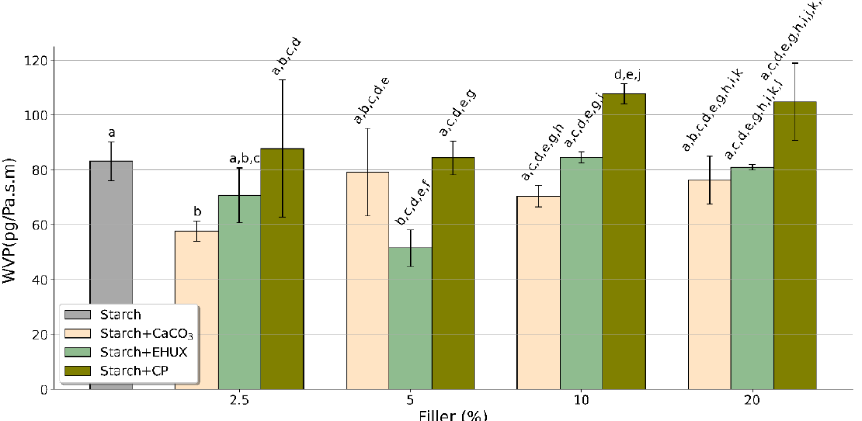
Figure 5. Water vapor permeability (WVP) of pristine starch films (control) and starch-based films containing commercial CaCO 3 , E. huxleyi (EHUX), or C. pseudoroscoffensis (CP) at different percent- ages (2.5, 5, 10, and 20% w / w ). Different letters between each condition indicate significant differ- ences (Student’s t -test; p < 0.05).